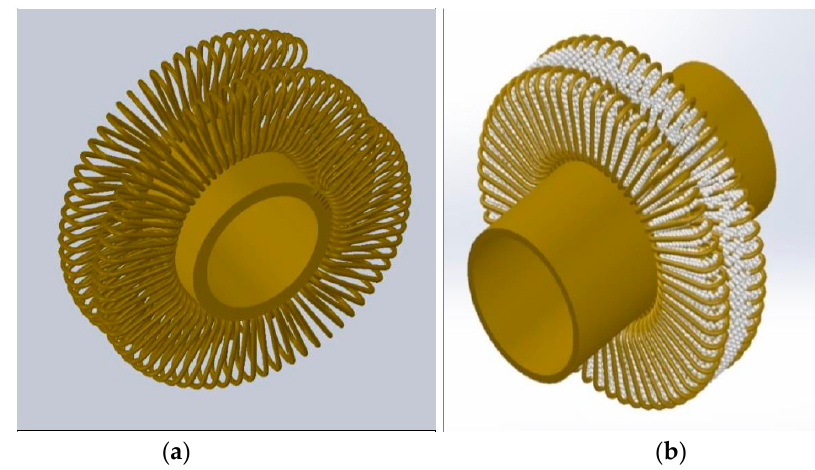
Figure 23. 3D model of the wire fin without silica gel and with silica gel. ( a ) The wire fin has no silica gel packing as can be seen from the 3D CAD model; ( b ) The heat exchanger has porous adsorbent added to it as can be seen in the 3D model.